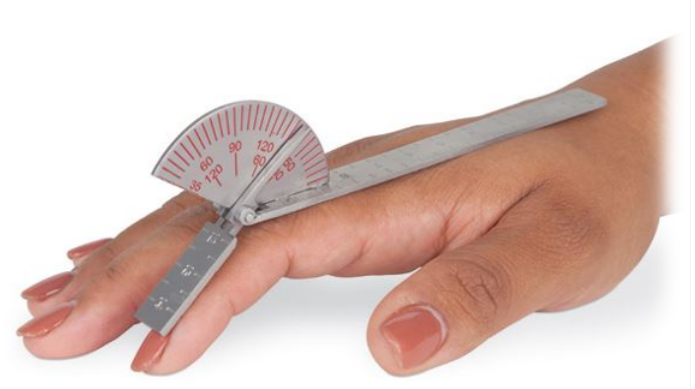
Figure 2. Universal goniometer (UG)